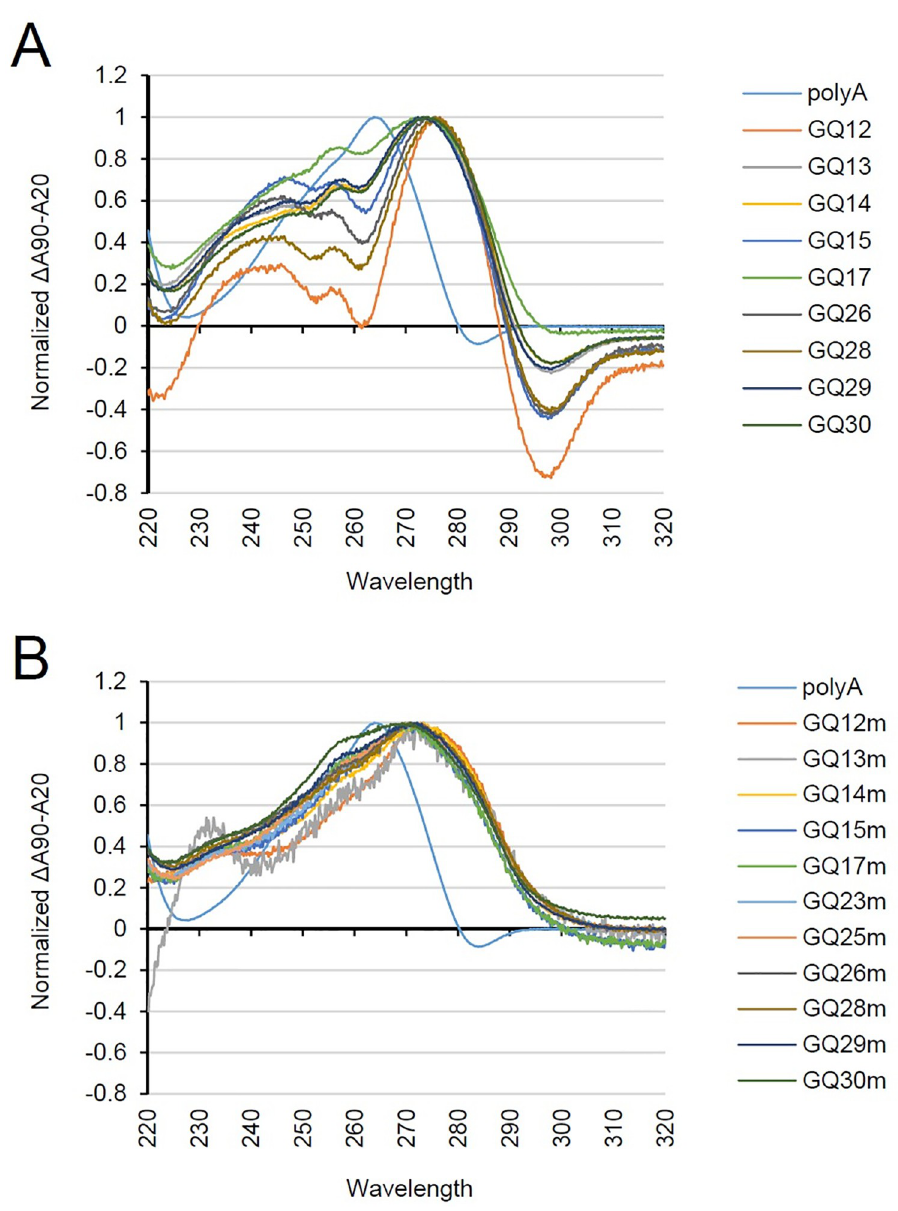
Fig 4. Normalized TDS spectra of ORF14 GQ ODNs from pOka. TDS spectra of wild-type (A) and mutant (B) ORF14 GQ ODNs (15 μ M) from pOka annealed in 10 mM Tris-HCl pH 7.5 and 100 mM KCl are shown. Each spectrum was an average of three accumulations in the wavelength range between 220–320 nm. The spectra were blanked with buffer only before TDS calculation. (S4 Fig). This ORF14-G4m DNA contains the same coding potential as the wild-type ORF14 (S5 Fig). The wild-type ORF14 and ORF14-G4m DNAs were cloned into the pSG5 vector con- taining the simian virus 40 early promoter [57] to express gC with a C-terminal HA-tag. gC is expressed as a ~64-kDa unmodified form and larger glycosylated forms [58]. In immunoblot- ting of lysates of 293T cells transfected with wild-type ORF14-HA and ORF14-G4m-HA plas- mids, we observed the unmodified form of gC-HA largely accumulated in transfected 293T